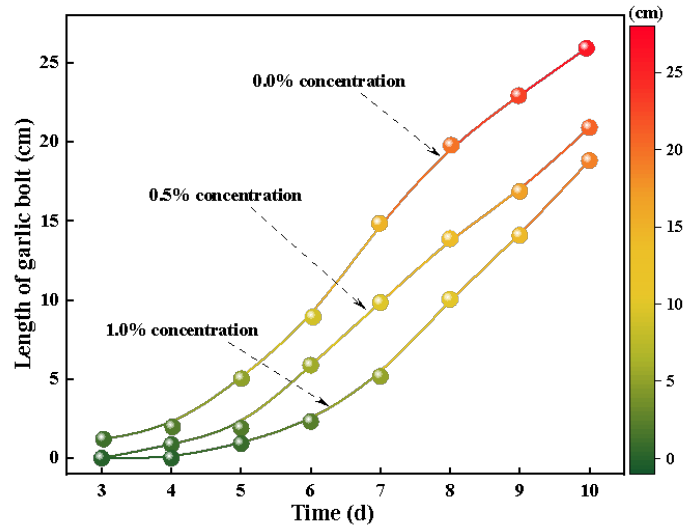
Figure 9. Length of garlic seedlings at different times.